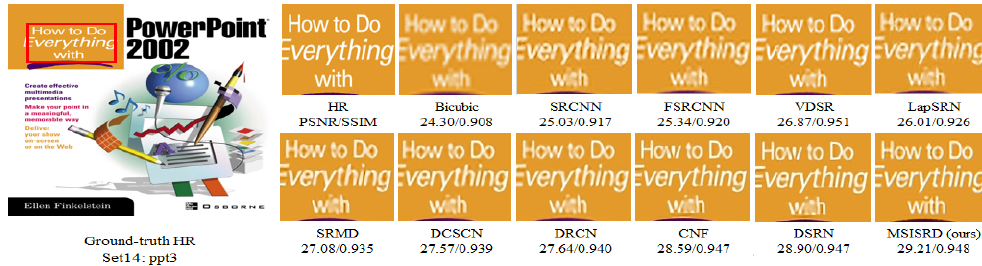
Figure 7. Visual performance of image “ppt3” from Set14 [63] dataset with 4 × scale factor enlargements [68].